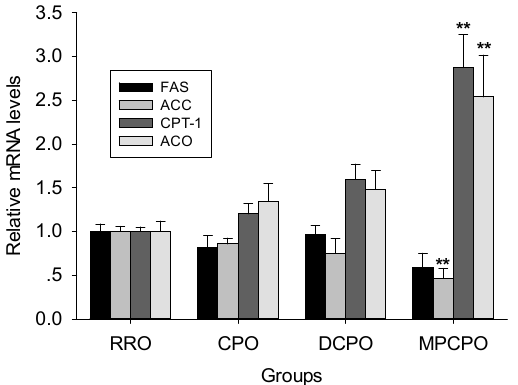
Figure 4. Effects of optimized rapeseed oils (OROs) on hepatic mRNA levels of fatty acid synthase (FAS), acetyl CoA carboxylase (ACC), carnitine palmitoyl transferase ‐ 1 (CPT ‐ 1), and acyl CoA oxidase